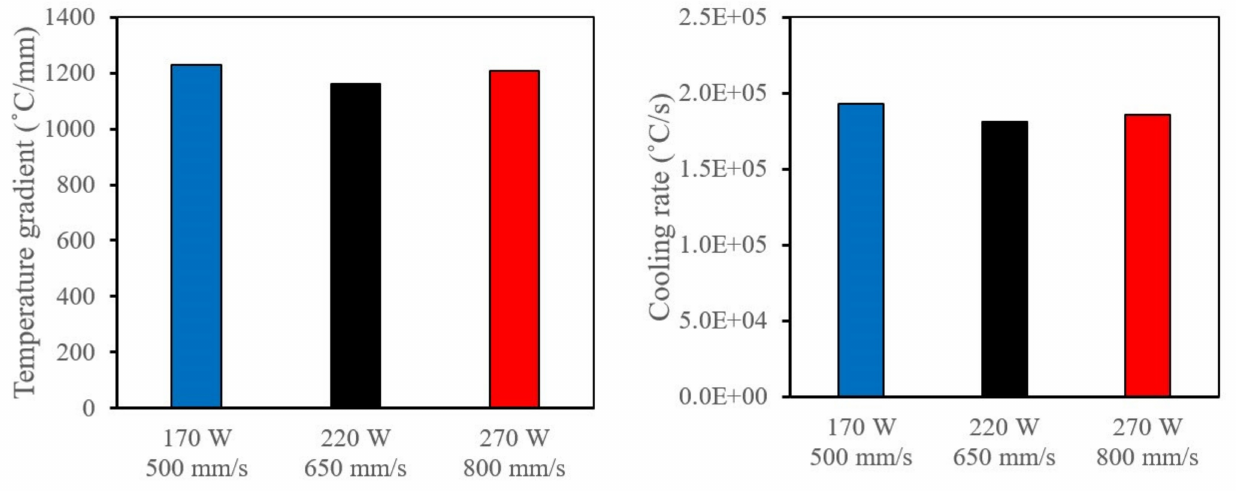
Figure 38. Effect of the same energy density of 2.82 J/mm 2 on ( a ) temperature gradient and ( b )